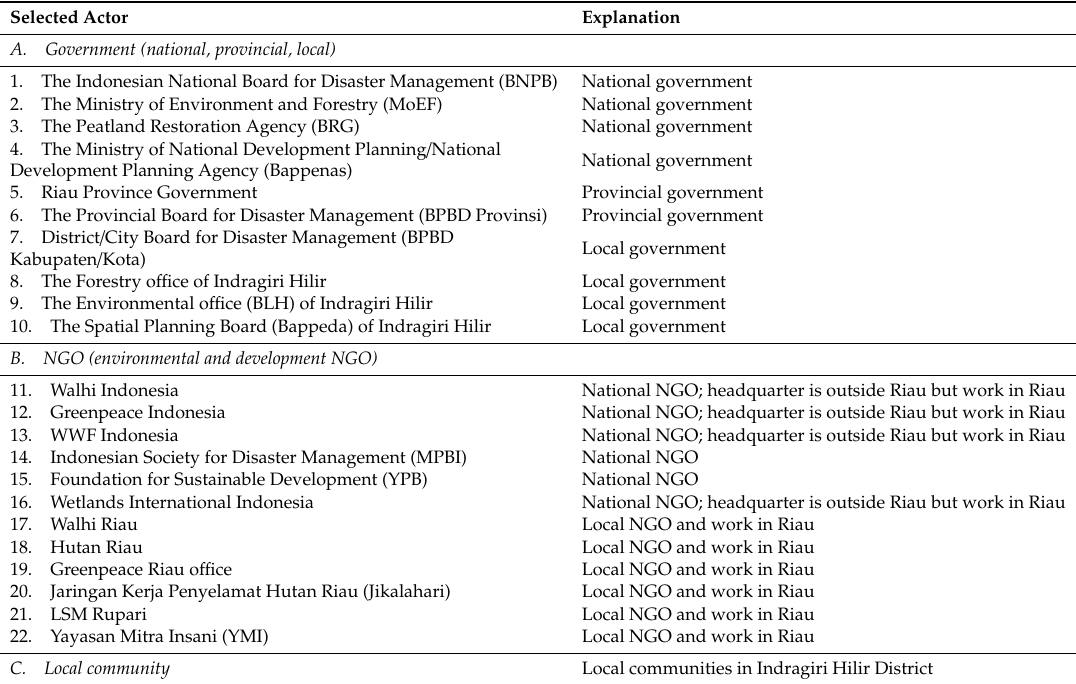
Table A1. List of selected